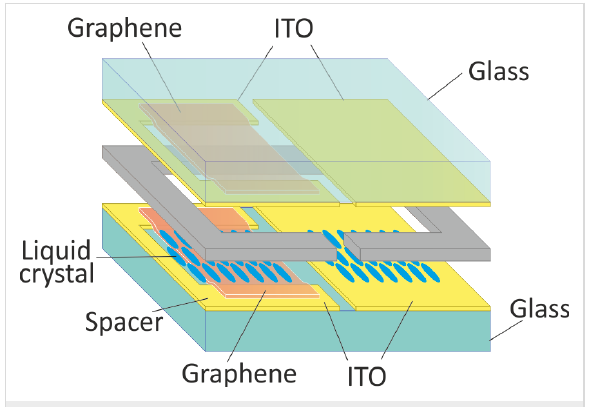
Figure 1: A schematic of the graphene–ITO hybrid liquid crystal cell.